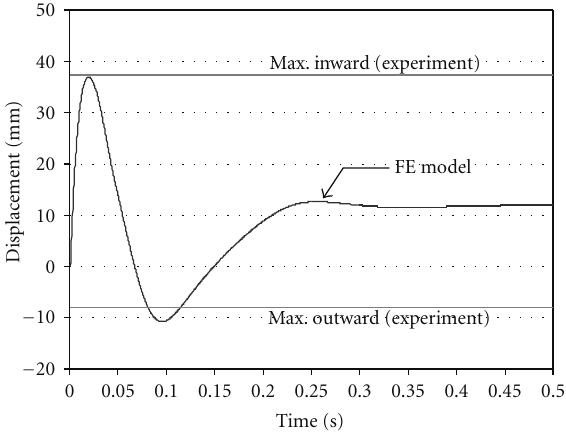
Figure 3: Comparison between deflections recorded from the experiment and the FE modeling exercise of the unretrofitted panel tested during Vietnam Trial 2.